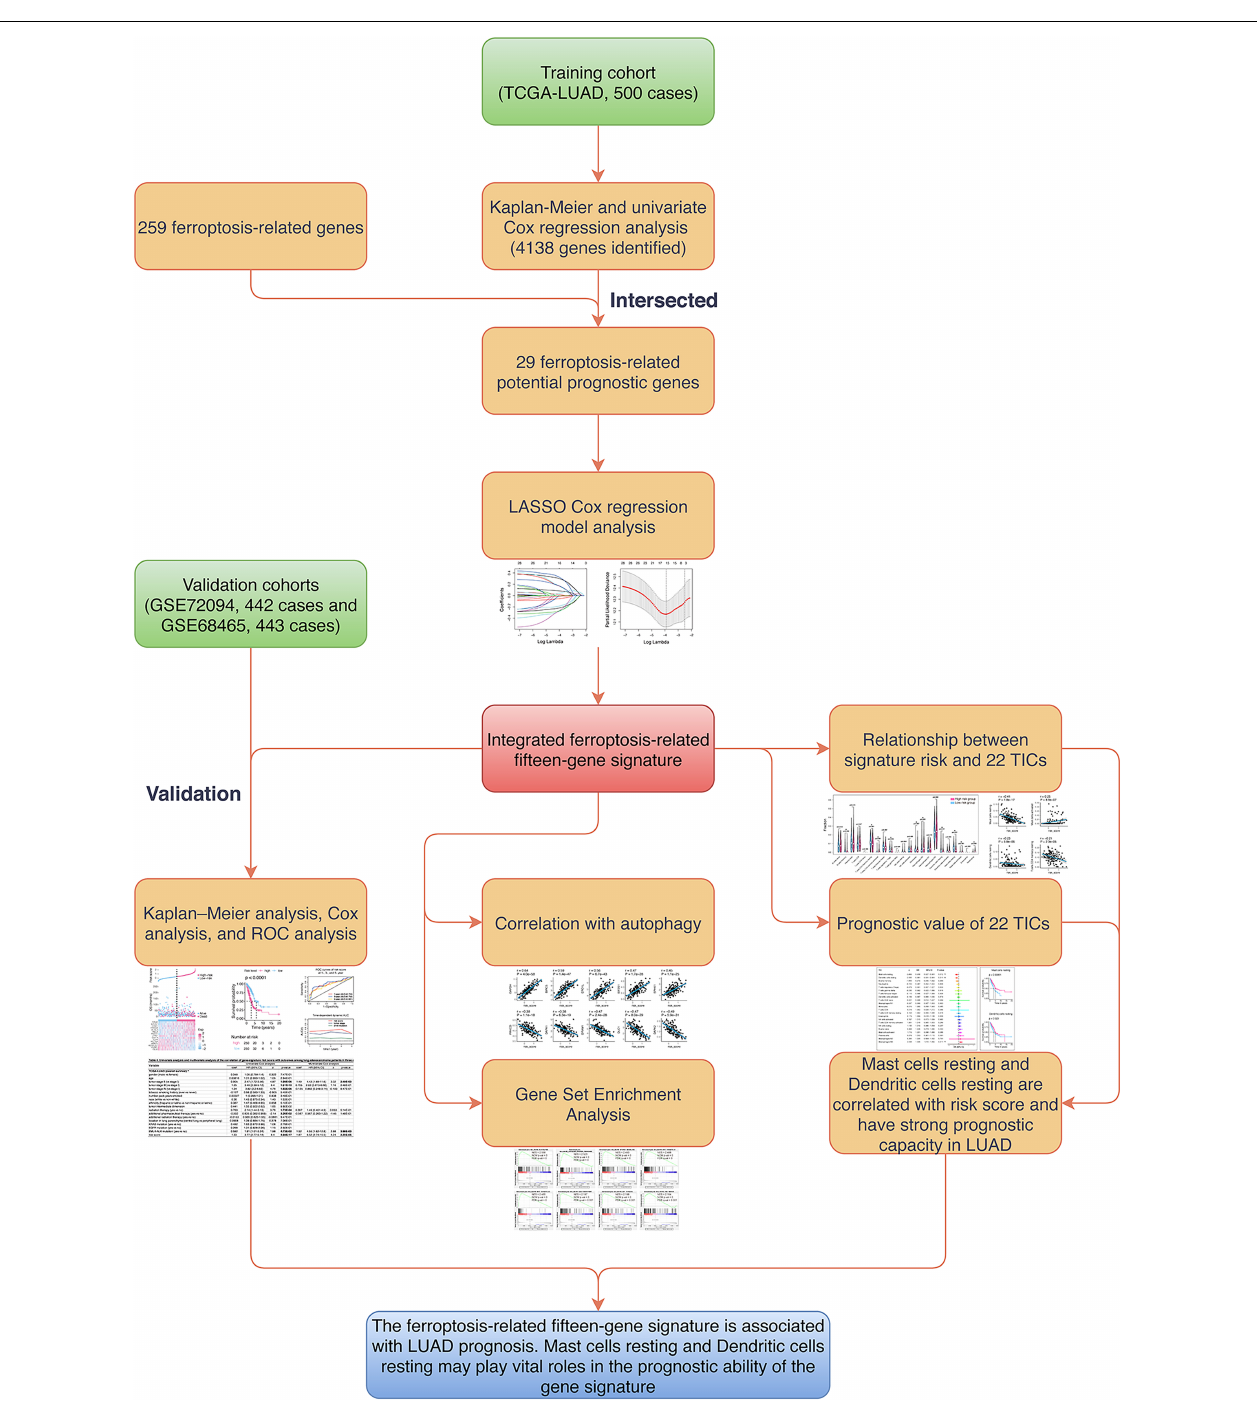
FIGURE 1 | Flowchart of the study. LASSO, the least absolute shrinkage and selection operator Cox regression model; ROC, receiver operating characteristic; UM, uveal melanoma; TICs, tumor-infiltrating immune cells.